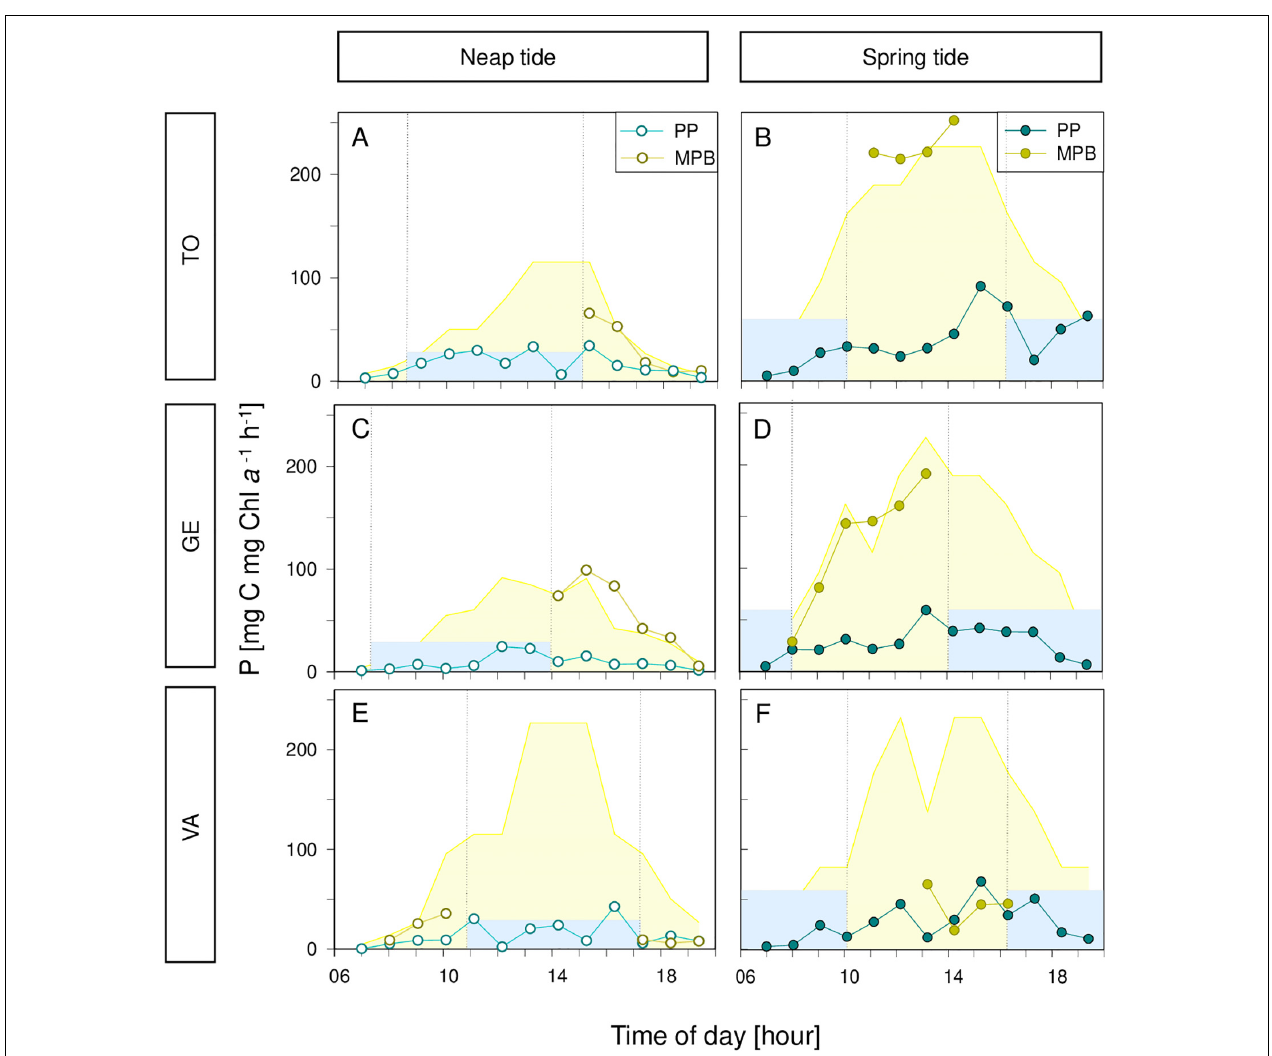
FIGURE 8 | Hourly rates of biomass-specific primary production of phytoplankton (PP) and microphytobenthos (MPB) along two days in July 2013, on tides (A,C,E) and spring tides (B,D,F) , at the three sampling sites, Torreira (TO; A,B ), Gafanha da Encarnação (GE; C,D ) and Vista Alegre (VA; E,F ). Areas in the background represent corresponding solar irradiance. Blue areas represent high tide; vertical bars demonstrate the beginning and end of the high